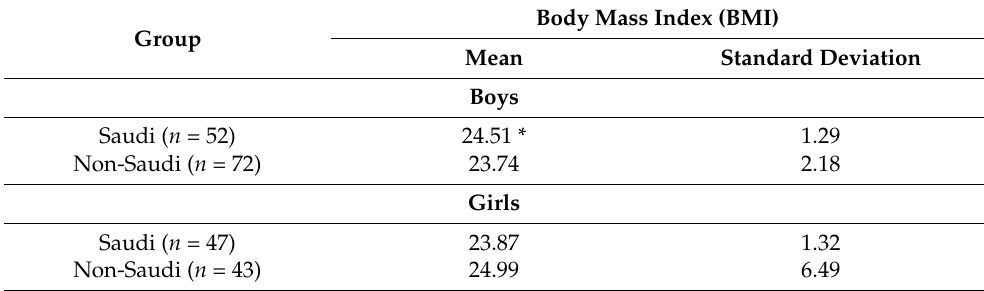
Table 2. Gender based body mass index (kg/m 2 ) of the Saudi (46%, n = 99) and non-Saudi (54%, n = 115) respondents.